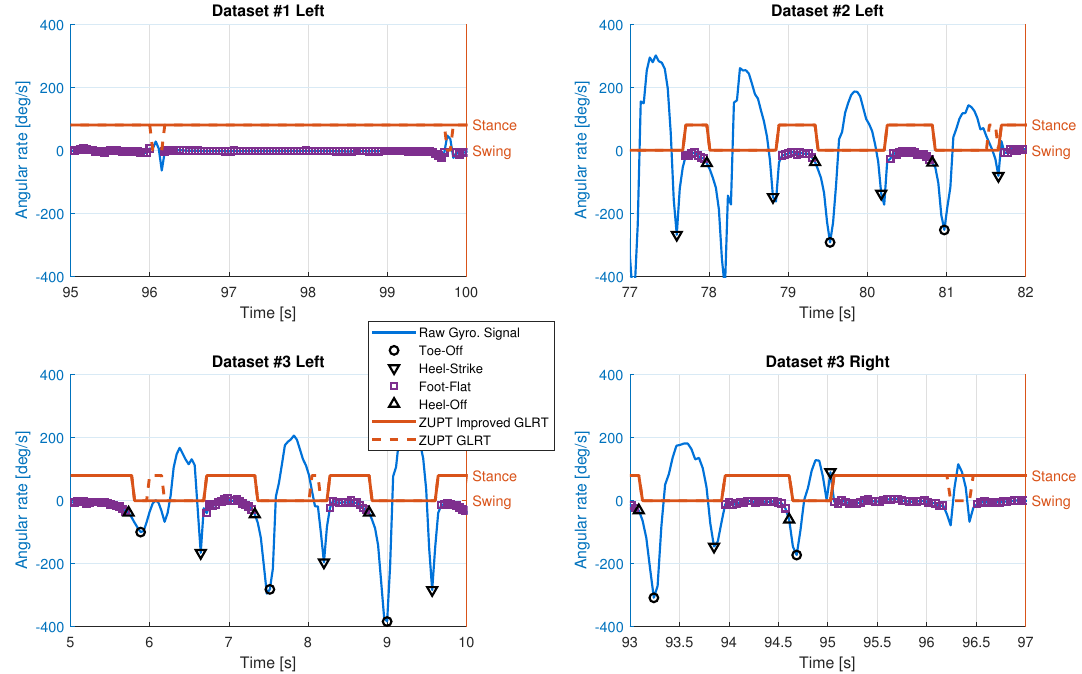
Figure 9. Missed and false step detections from three datasets. ( top left ) False swing detections from left foot of Dataset #1. ( top right ) False stance detection from right foot of Dataset #2. ( bottom left ) False stance detections from left foot of Dataset #3. ( bottom right ) Missed swing detection from right foot of Dataset #3.